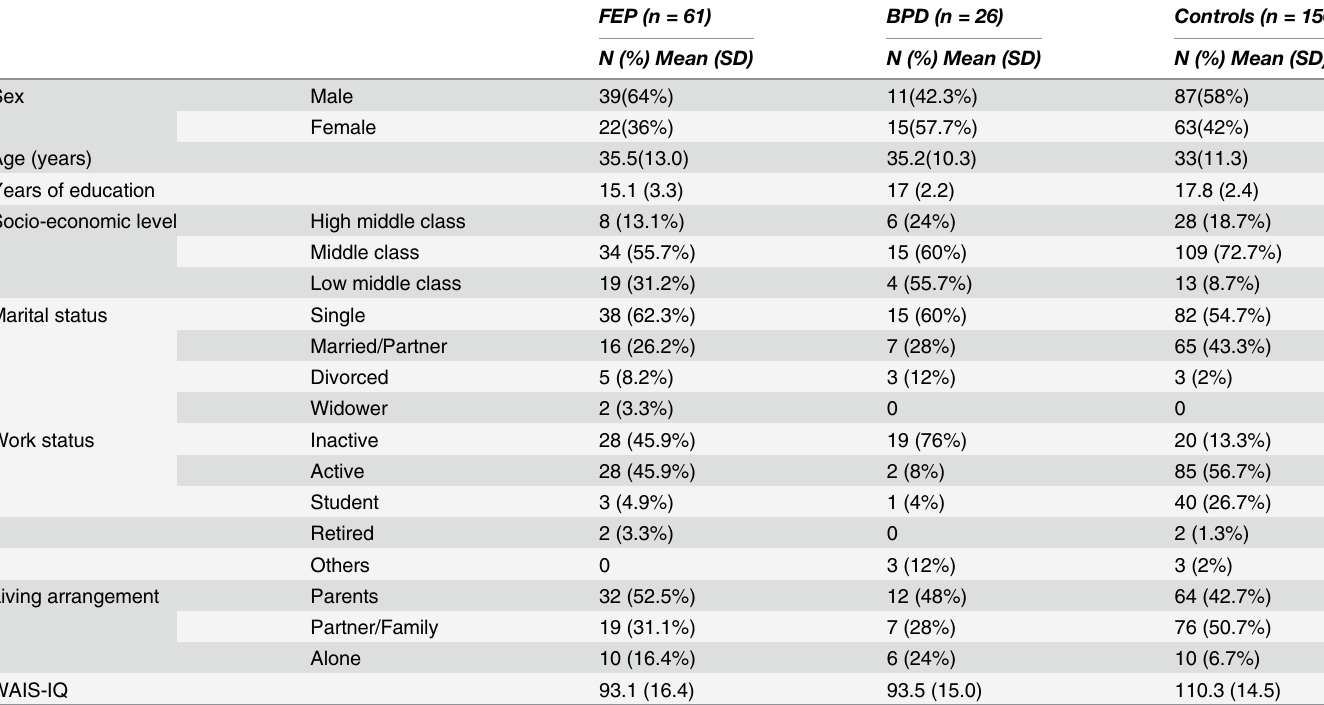
Table 1. Sociodemographic variables.